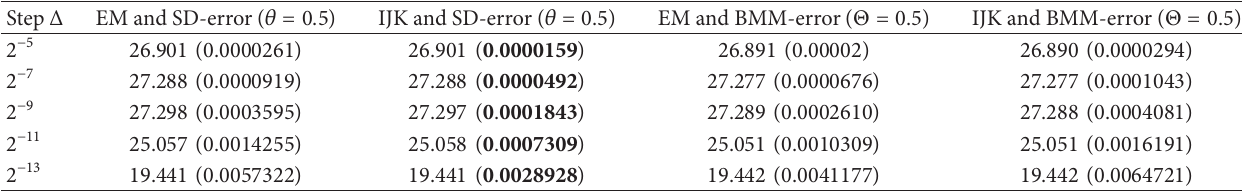
Table 6: 98% error, step size, and average computational time of numerical integration of process (𝑆 𝑡 ) using log-Euler or IJK method with SD or BMM scheme for (1) with (𝑥 0 ,𝑆 0 ,𝜇,𝑘 1 , 𝑘 2 ,𝑘 3 , 𝑞, 𝑇) = (1/16, 100, 0.05, 1/16, 1,0.4,3/4, 1) and correlation 𝜌 = 0 . EM and SD-error (𝜃 = 0.5)